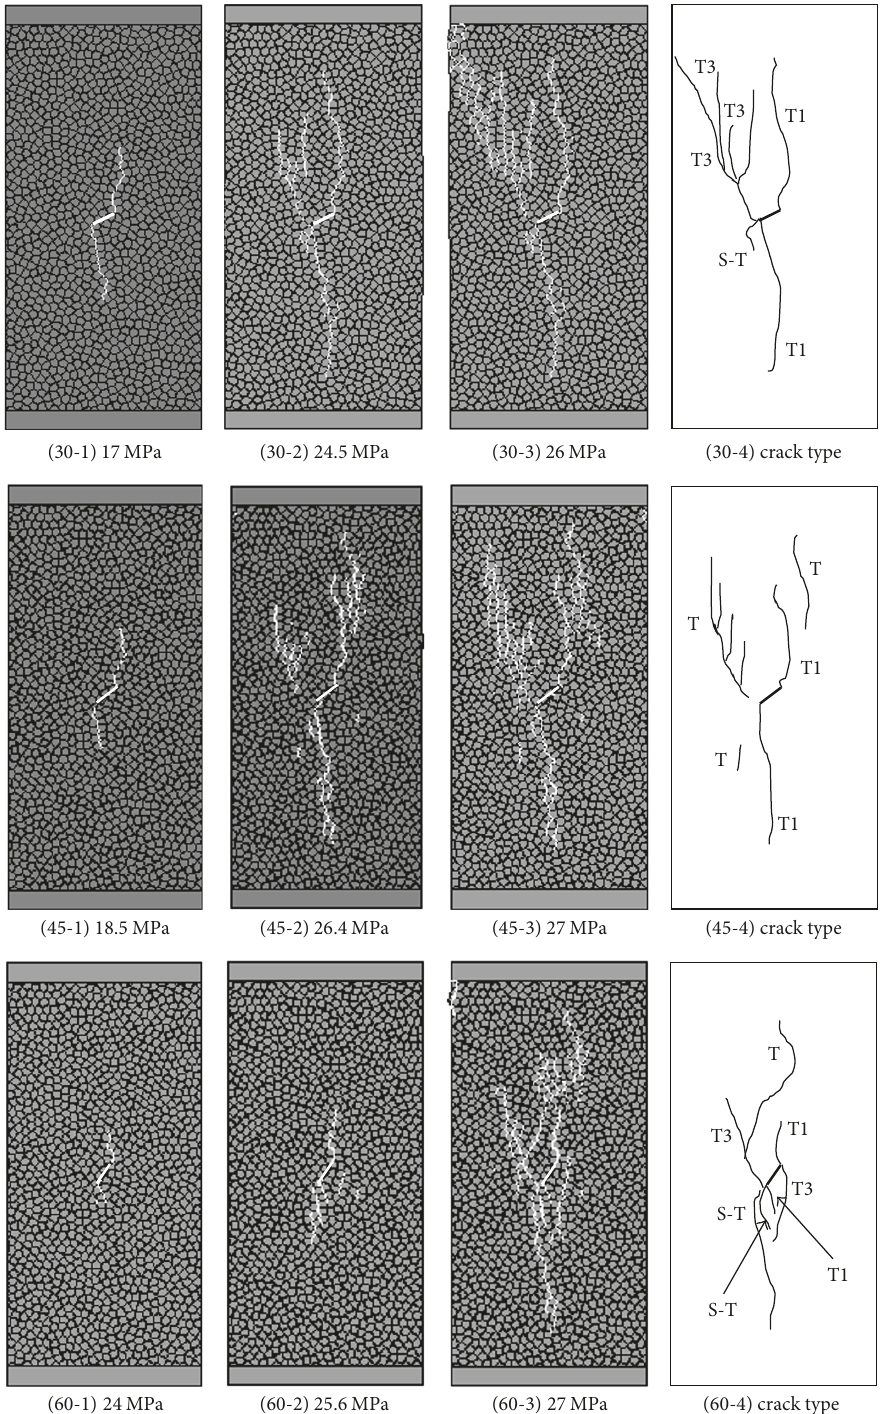
Figure 14: The failures modes at different inclination angles ( 𝛽 ). Length of the preexisting flaws is 10 mm. T: tensile crack, S: shear crack, and the number represents crack